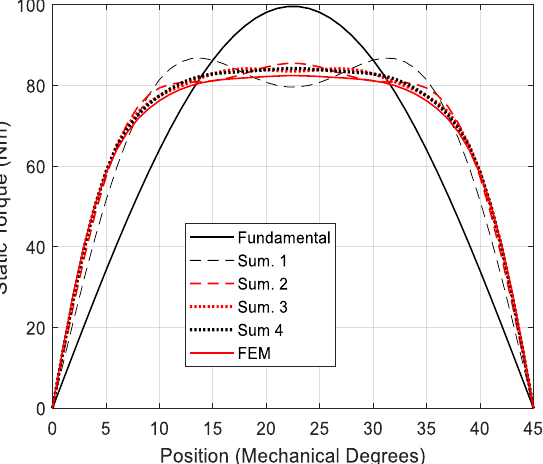
Figure 11. Static torque comparison with different harmonic numbers and FEM, case one.